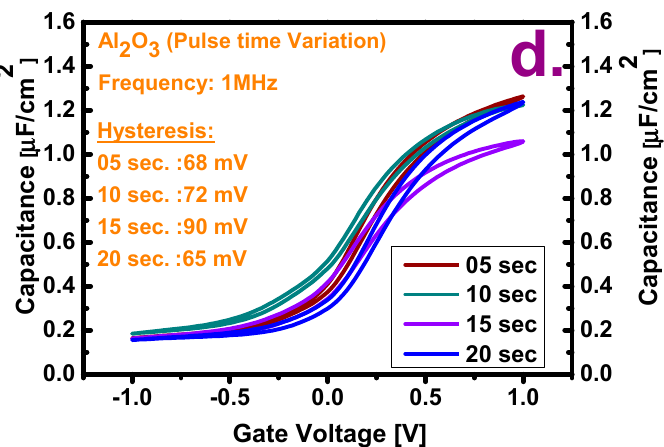
Figure 1. Frequency dispersion (10 kHz–1 MHz) C–V response of the annealed Al 2 O 3 films ( a ) deposited at three temperatures (200, 250, and 300 °C) with a purge time of 20 s and ( b ) deposited with four purge times (5, 10, 15, and 20 s) at a deposition temperature of 250 °C. Comparison of hysteresis measured at 1 MHz from − 1 V to +1 V for Al 2 O 3 films ( c ) deposited at three temperatures (200, 250, and 300 °C) with purge time of 20 s and ( d ) deposited with four purge times (5, 10, 15, and 20 s) at a deposition temperature of 250 °C.